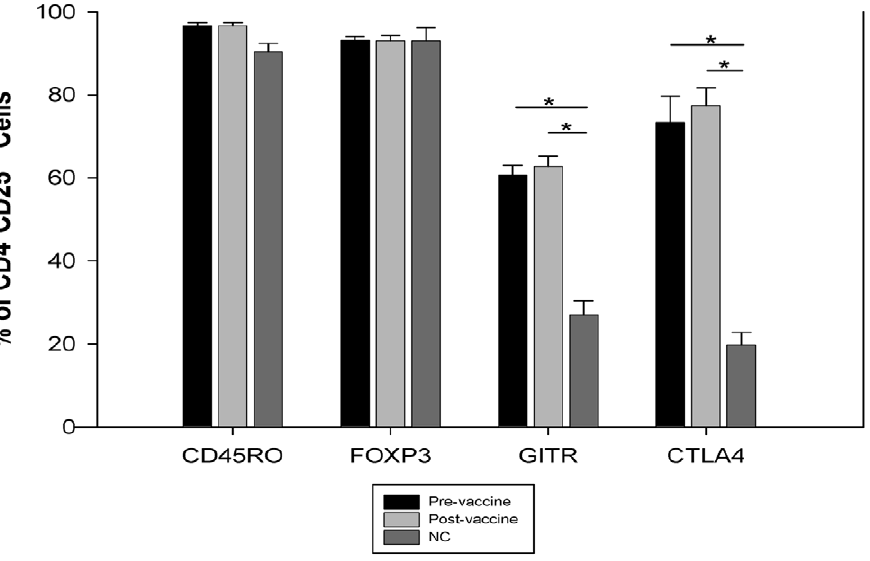
Figure 3. Comparison of CD45RO, FOXP3, GITR, and CTLA4 expression. The mean percentage expression in CD4 + CD25 HI T cells was compared among normal control (NC; N=10) and the HIV-1-infected subjects pre- and post-vaccine (N=17). CD4 + CD25 HI expression of GITR and CTLA4 in HIV-1-infected subjects (pre- and post-vaccine) was higher than in NC. (P , 0.01)